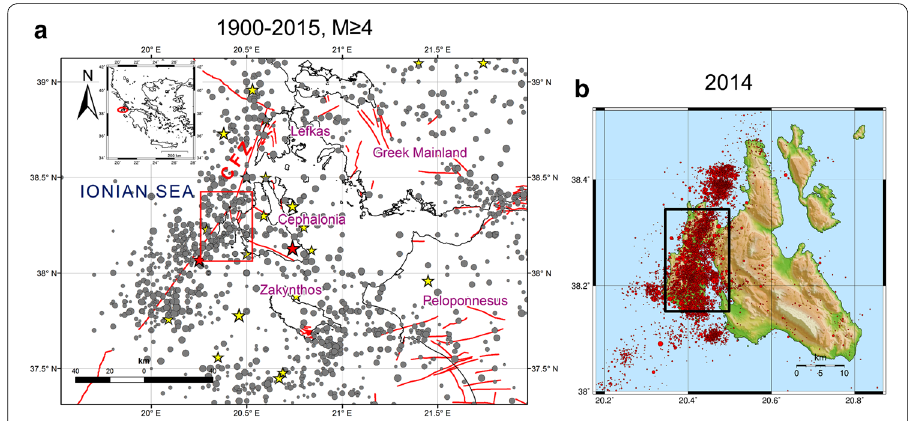
Fig. 1 a Instrumental seismicity in the broader study area (1900–2015; M dynamics www.gein.noa.gr). Yellow and red stars present epicenters of earthquakes with M respectively. The size of the symbols is proportional to the magnitude of the events. Red lines denote active faults [12]. The red rectangle surrounds the study area. The embedded map shows the position of the broader study area within the Greek territory. CFZ Cephalonia Fault Zone. b Spatial distribution of the 2014 sequence with the use of an optimum local velocity model